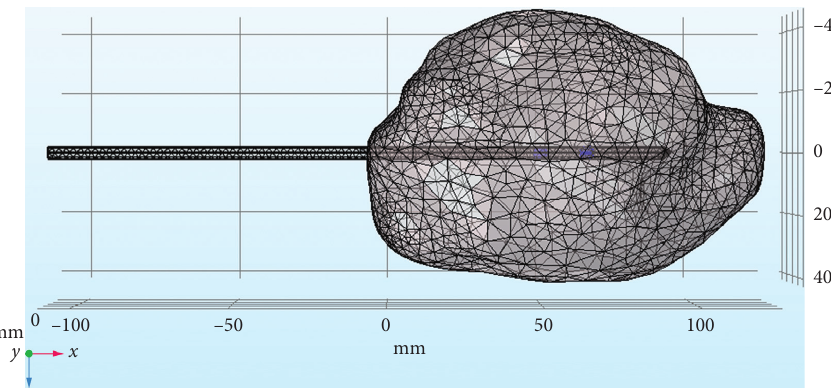
Figure 1: Schematic diagram of traditional drainage tube.